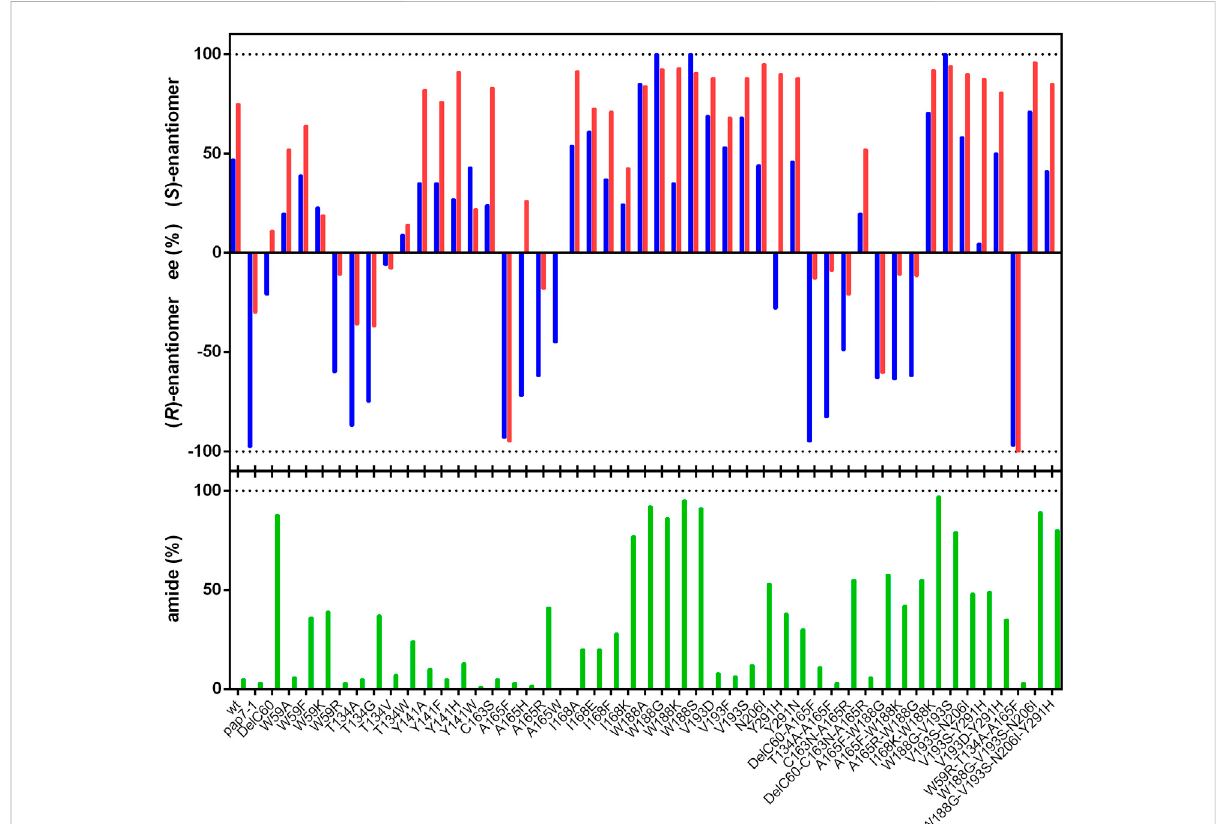
FIGURE 2 Conversionof rac -phenylglycinonitrilebyvariantsofthenitrilasefrom P. fl uorescens EBC191.Thereactionmixturescontainedina fi nalvolume of 1 ml resting cells of E. coli JM109 Δ pepA (pIK9-variant) (OD 600nm = 0.1 – 2.5) in 100 mM potassium-phosphate buffer (pH 6.0). The biotransformationreactionswereinitiatedbyadding100 µlofa rac -PGAAstocksolution(100 mMinmethanol),andincubatedat23 ° Cand750 rpm. After different time intervals, samples (90 µl) were taken and the reactions were terminated by the addition of 10 µl of 1 M HCl. The cells were removed by centrifugation (20,000 g , 2 min) and the supernatants were subsequently analyzed by chiral HPLC. The ee values and the degree of amide formation were determined at about 30% conversion. The ee -values for the formed PGA and PGAA are given in blue and red,